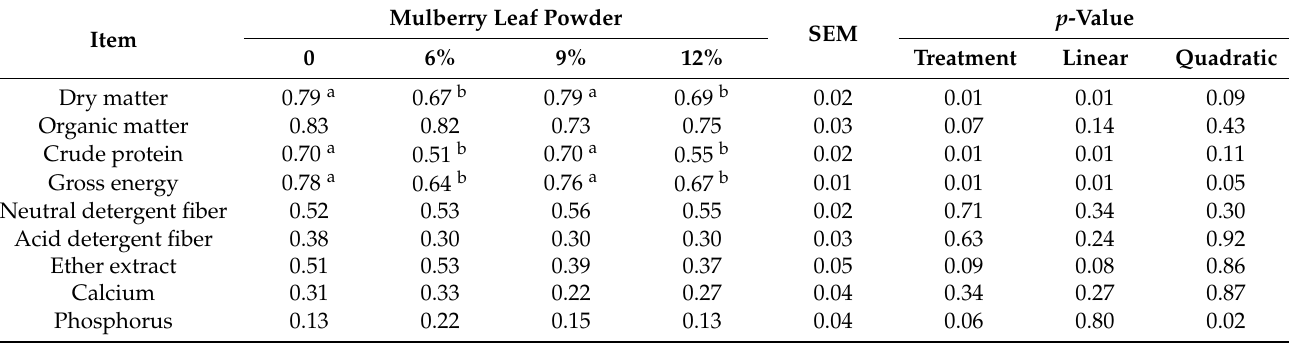
Table 4. Effect of mulberry leaf powder of varying levels on nutrient digestibility in finishing